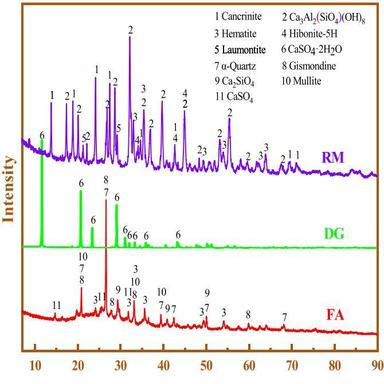
XRD pattern of raw materials.